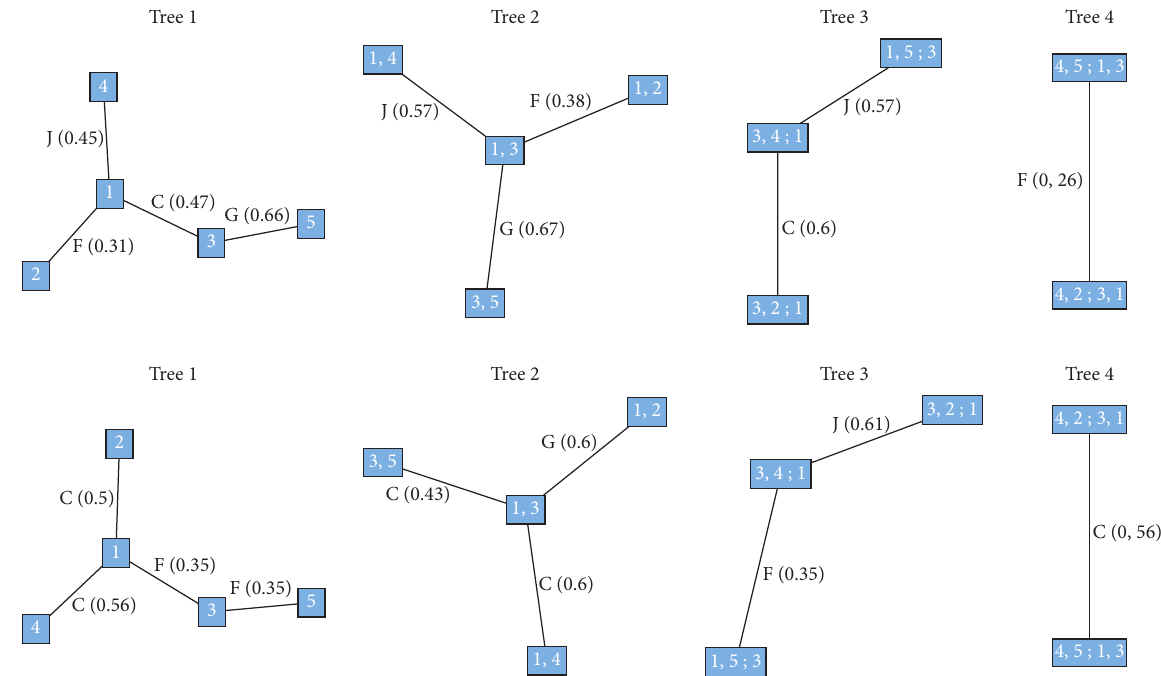
Figure 2: Construction plots of the mixture components. Top: first component. Bottom: second component. F: Frank, J: Joe, G: Gumbel, and C: Clayton. The values inside the parentheses are the Kendall tau’s values.